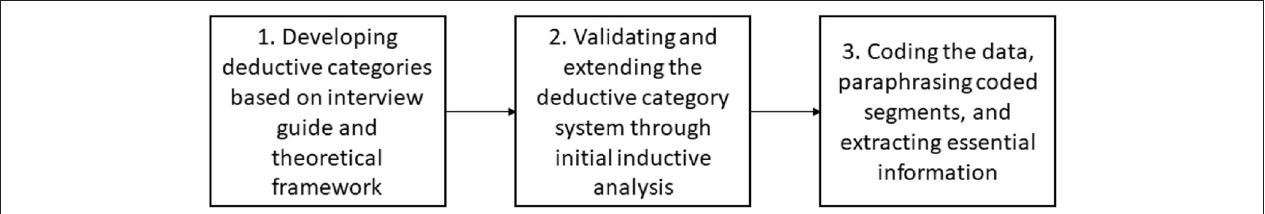
FIGURE 3 | Summary of the steps involved in qualitative structuring content